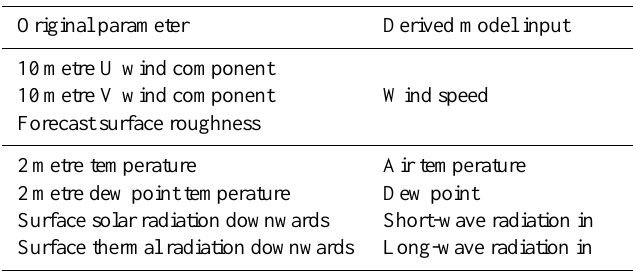
Table 2. The data acquired from the ECMWF’s ERA-Interim